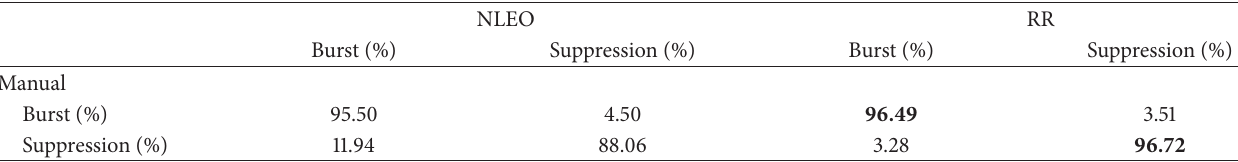
Figure 8: The boxplot of two different indexes at the burst, suppression, and normal states. (a) Approximate entropy. (b) The RR index. Table 3: The confusion matrix between the NLEO and the